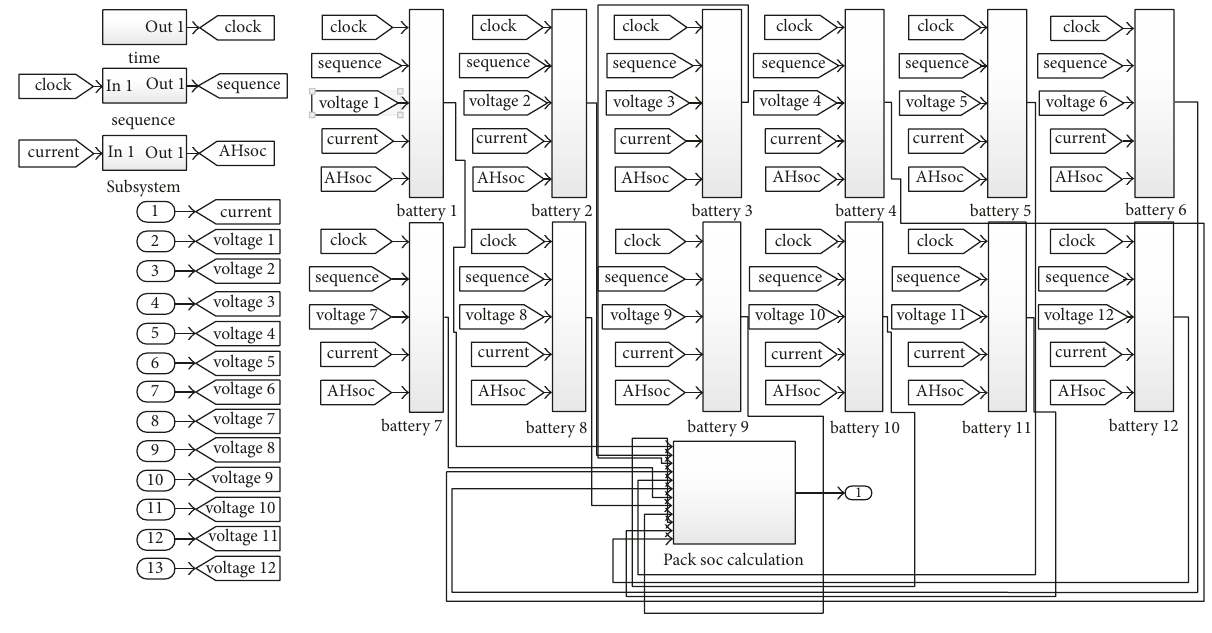
Figure 11: System simulation model.